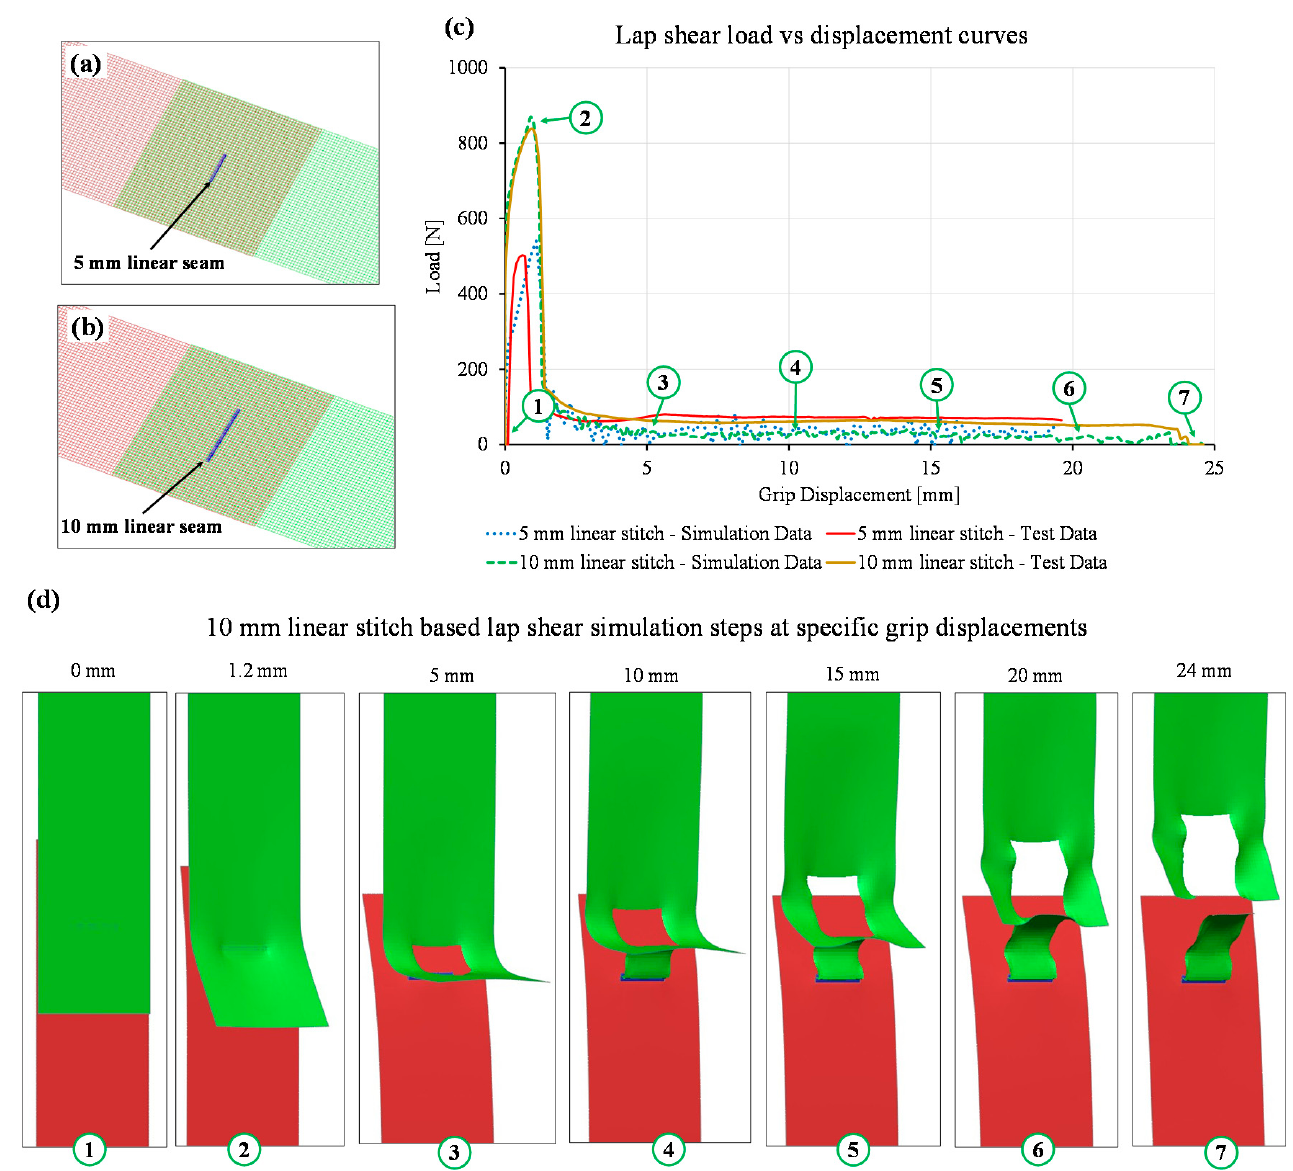
Figure 12. Simulation of linear stitch-based lap shear models: ( a ) mesh representation of 5 mm linear seam, ( b ) mesh representation of 10 mm linear seam ( c ) comparison of load–displacement curves obtained from simulation and tensile tests of 5 mm and 10 mm laser micro-welds, and ( d ) sequence of images from the simulation at specific grip displacement obtained from the simulation of the 10 mm linear seam.